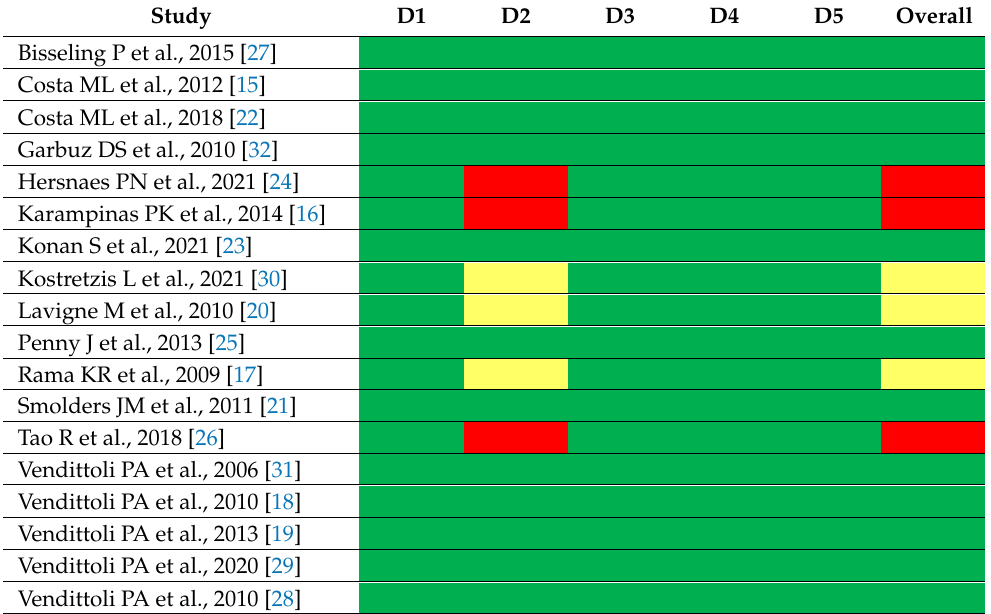
Table 3. Risk of bias assessment using the RoB2